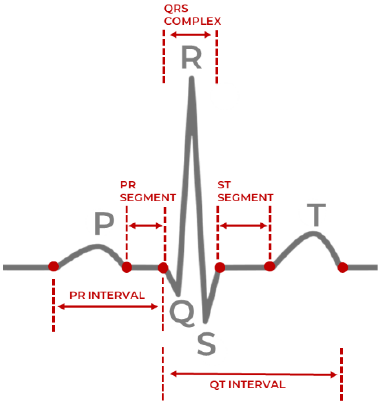
Figure 1. Single heartbeat sample with the QRS complex [4].